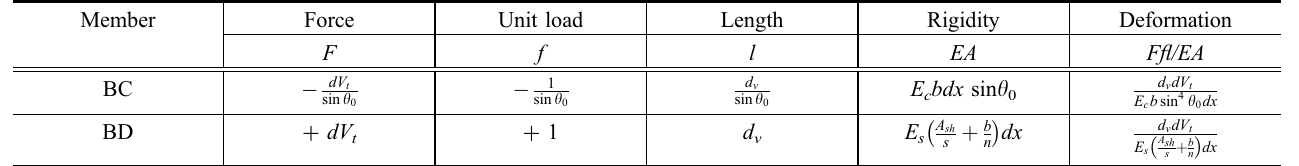
Table 1 Chord deformations of CATM by the principles of virtual work method. Member Force Unit load